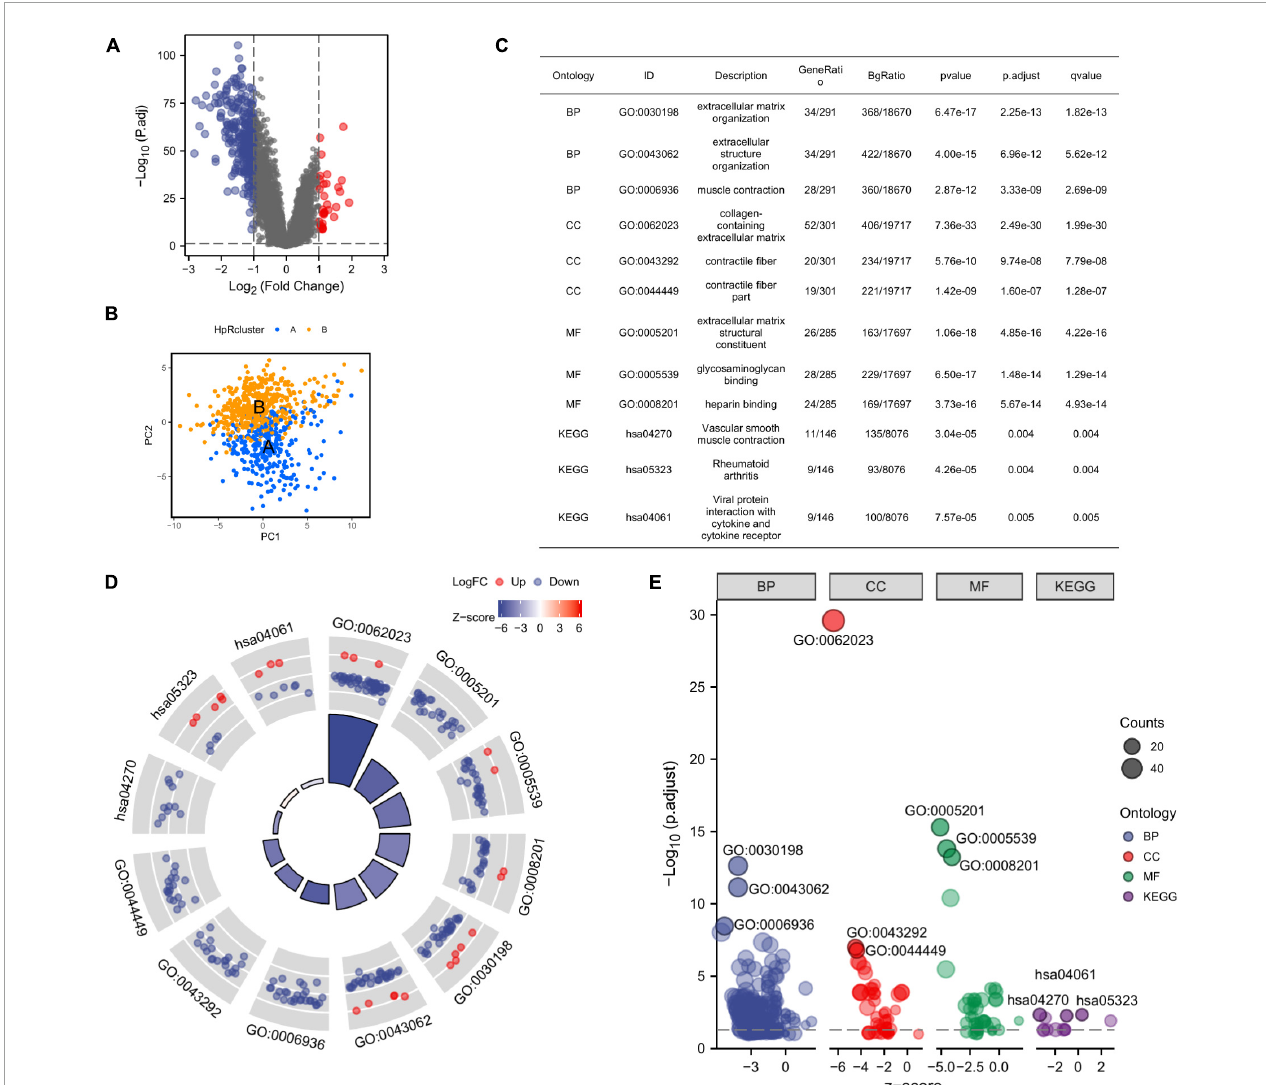
FIGURE5 Identification of DEGs between the two subtypes and the corresponding functional enrichment. (A) A volcano plot corresponding to the regulation of DEGs in two subtypes, the default set of threshold was foldchange ≥ 2. (B) PCA plot exhibiting the distinctions in transcriptomes between the subtype A and B. (C) The description of GO terms and KEGG pathways of DEGs. (D) GO and KEGG analysis of DEGs (the top 12 are shown). (E) GO Bubble plot displaying expression level of DEGs in different terms. DEGs, differential expression genes; GO, Gene Ontology; KEGG, Kyoto Encyclopedia of Genes and Genomes; PCA, principal component